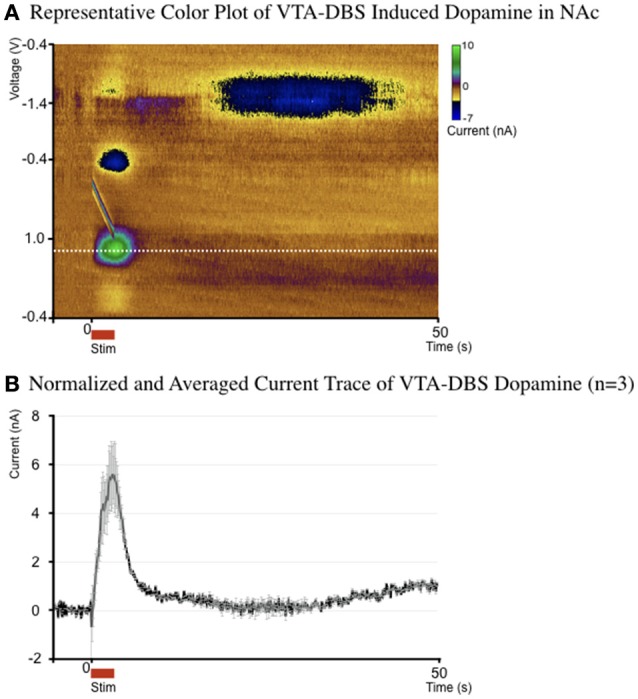
(A) Representative pseudo-color plot of dopamine oxidation (0.6 V) and reduction (−0.2 V) following VTA-DBS. (B) The average (± standard error) current by time trace of a single representative dopamine response, at the dopamine oxidation voltage for the 3 subjects who underwent electrochemical evaluation (normalized to the average background current).